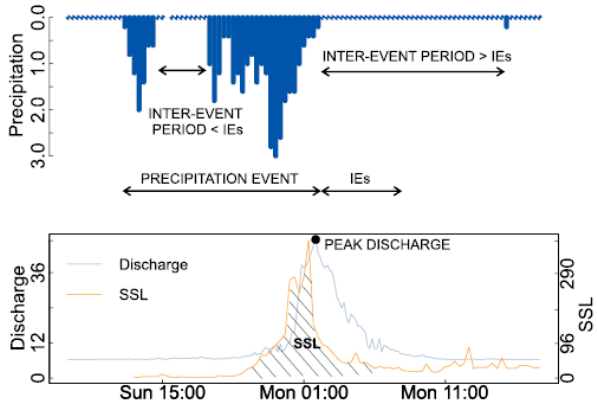
Figure 2. Graphical presentation of an event-based definition of variables used in the proposed copula model.